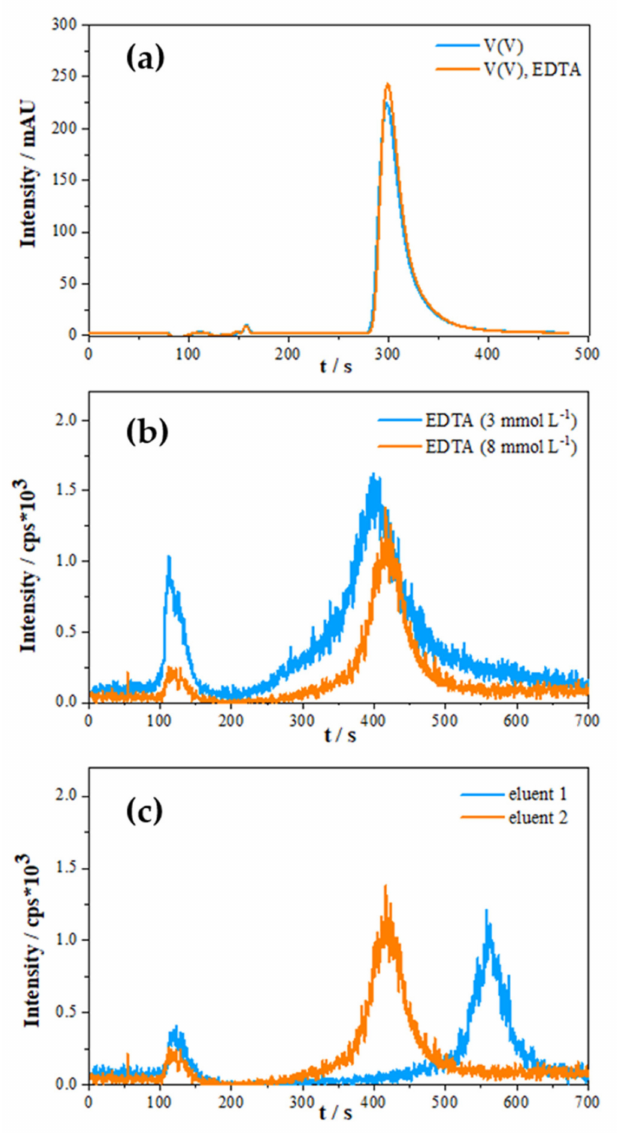
Figure 3. ( a ) Comparison of chromatograms for measured solutions using eluent composed from 40 mmol L –1 HCO 3– , 40 mmol L –1 SO 42– , 8 mmol L –1 EDTA and 3% acetonitrile on IC-UV/Vis containing: V(V) (0.1 mmol L − 1 ) in MQ–blue line; V(V) (0.1 mmol L − 1 ) complexed withEDTA (1 mmol L − 1 ) in MQ– orange line; ( b ) comparison of IC–ICP–MS chromatograms in seawater sample (salinity= 38). Eluent containing 3 mmol L –1 EDTA, 40 mmol L –1 HCO 3– , 40 mmol L –1 SO 42– and 3% acetonitrile (blue line) and 8 mmol L –1 EDTA, 40 mmol L –1 HCO 3– , 40 mmol L –1 SO 42– and 3% acetonitrile (orange line) are used. ( c ) Eluents containing 80 mmol L –1 HCO 3 − , 8 mmol L –1 EDTA and 3% acetonitrile (blue line, eluent 1) or 40 mmol L –1 HCO 3– , 40 mmol L –1 SO 42– , 8 mmol L –1 EDTA and 3% acetonitrile (orange line, eluent 2) are